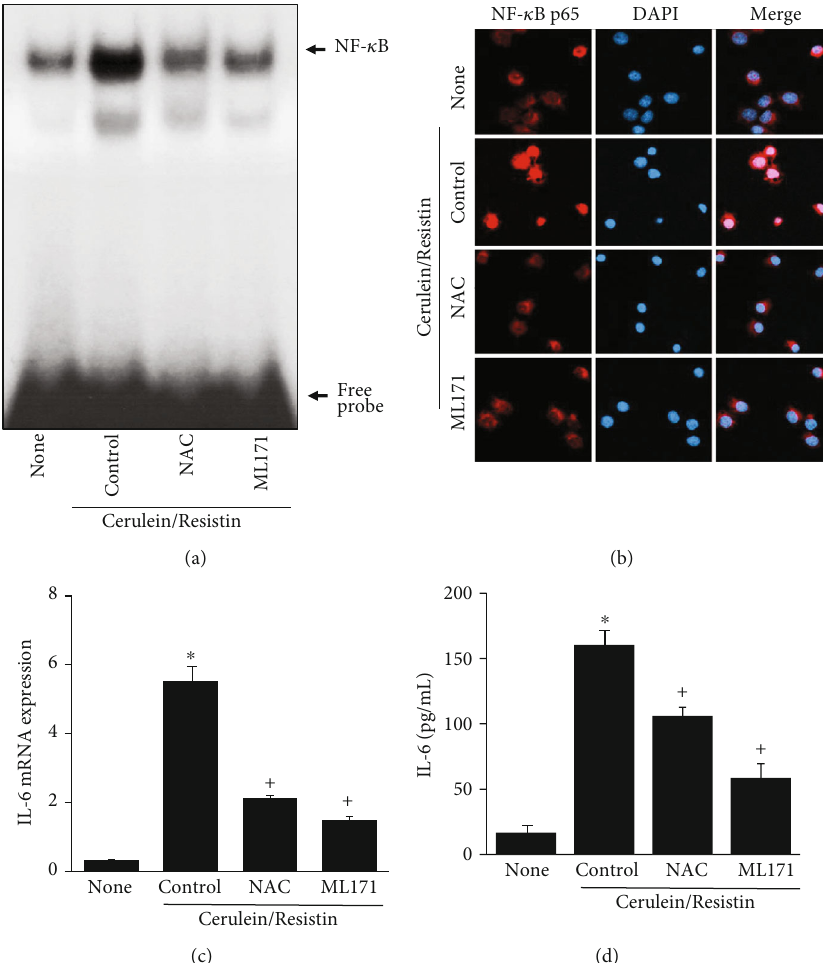
Figure 7: NAC and BAPTA-AM inhibits cerulein/resistin-induced NF- κ B activation and IL-6 expression in AR42J cells. The cells were pretreated with NAC (1 mM) or ML171 (2 μ M) for 1 h and then stimulated with cerulein/resistin for 1h (for NF- κ B-DNA binding activity (a) and nuclear translocation of NF- κ B p65 (b)), for 6 h (for IL-6 mRNA level (c)), and 24 h (for IL-6 protein level (d)). (a) NF- κ B-DNA binding activity was determined by electrophoretic mobility shift assay (EMSA). (b) The immunoreactive NF- κ B p65 was visualized using a rhodamine-conjugated mouse anti-rabbit IgG antibody (red) with DAPI counterstaining (blue) of the same fi eld. (c) The mRNA expression level of IL-6 was determined by real-time PCR analysis and normalized to that of β -actin. (d) The protein level of IL-6 in the media was determined by enzyme-linked immunosorbent assay (ELISA). Data are expressed as the mean ± S : E : of three di ff erent experiments. ∗ p < 0 : 05 vs. none (untreated cells); + p < 0 : 05 vs. cerulein (cells treated with cerulein